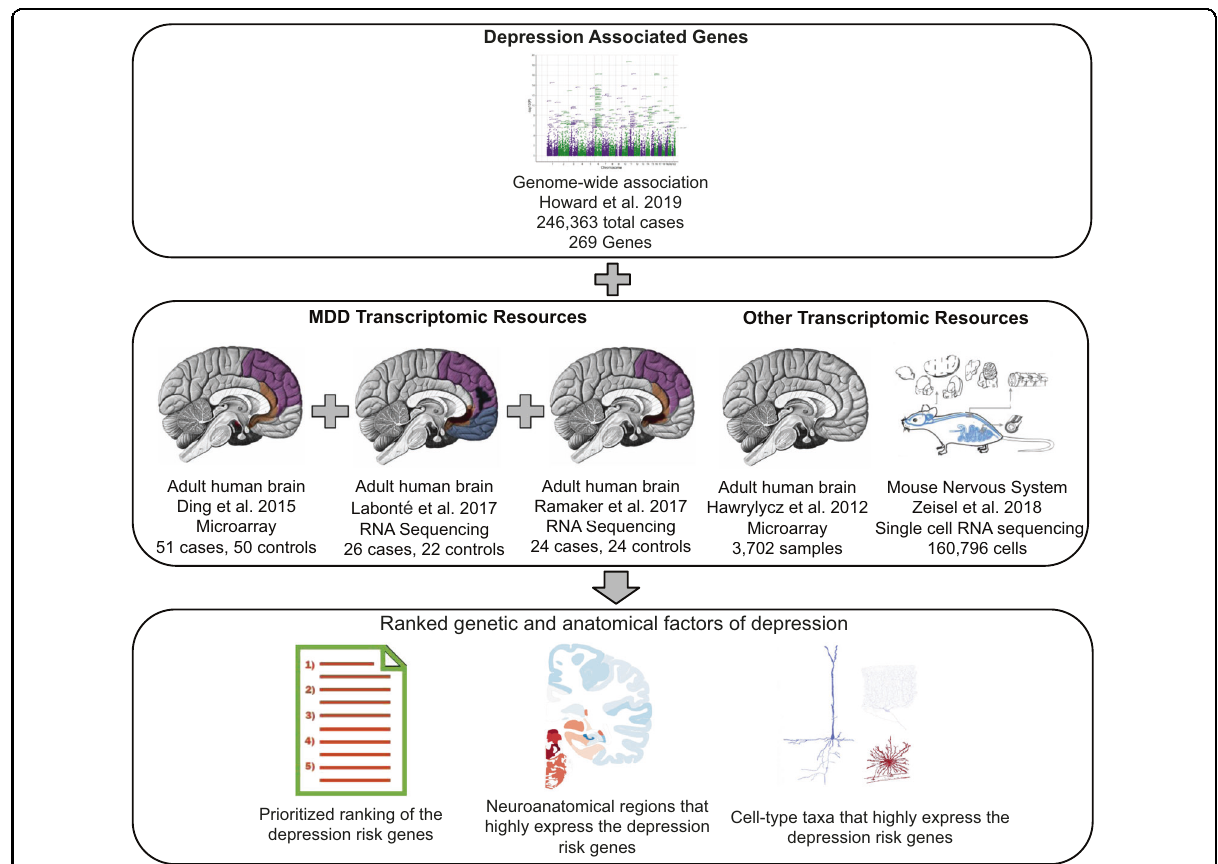
Fig. 1 Overview of this study. The 269 genes implicated with depression (top) are characterized by several transcriptomic studies (middle). Highlighted are the different brain regions sampled within each study (middle) that will help prioritize the genes (bottom). Other transcriptomic resources that were used (middle) will identify anatomical targets associated with the disease (bottom). Images are from the cited publications, Dr. David M Howard, and Wikimedia Commons (Gray ’ s Anatomy by Henry Vandyke